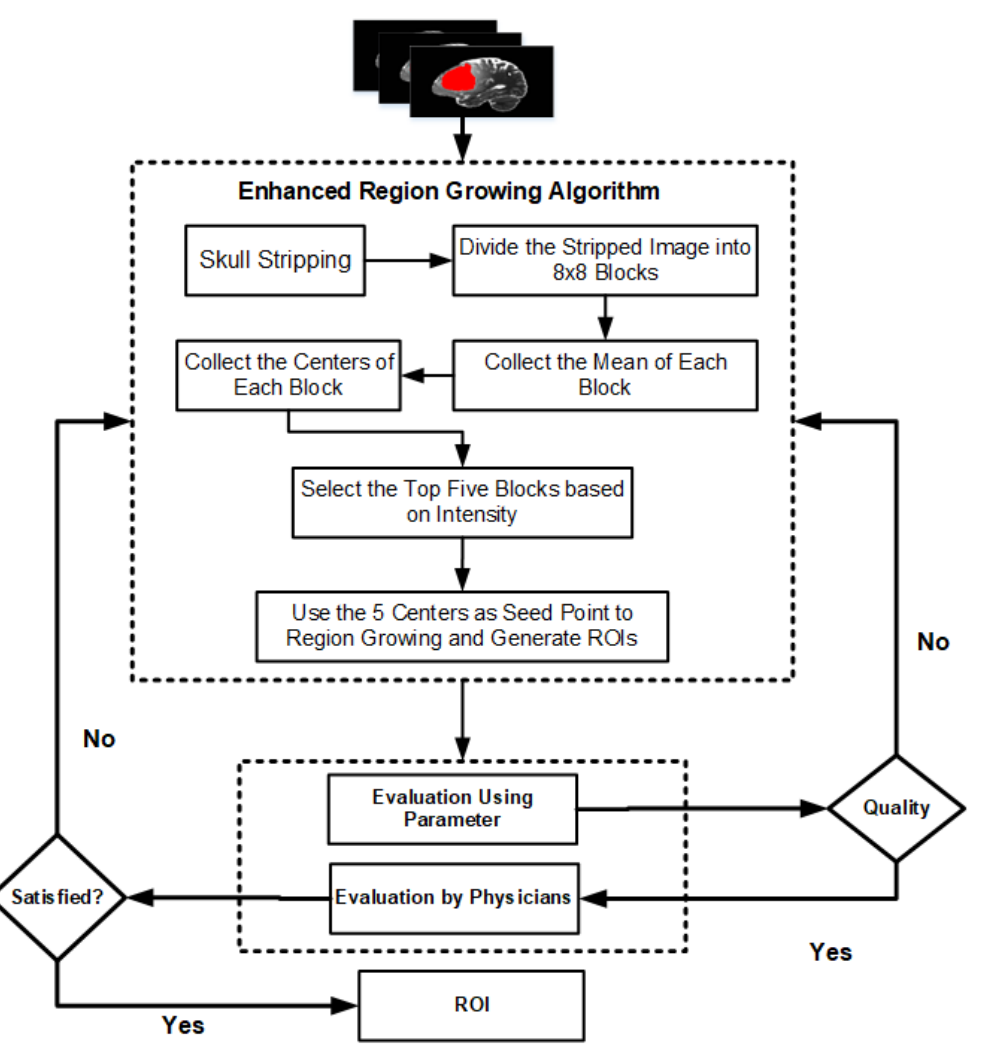
Figure 1. Flowchart of the proposed region growing algorithm. In this approach the segmentation result is evaluated both by evaluation parameters and